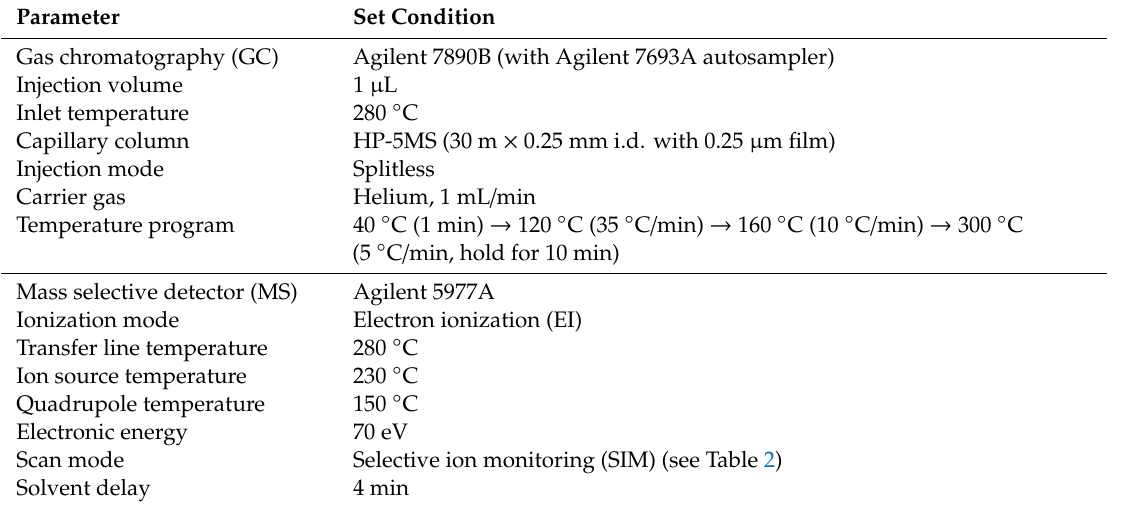
Table 1. Parameters of the GC-MS